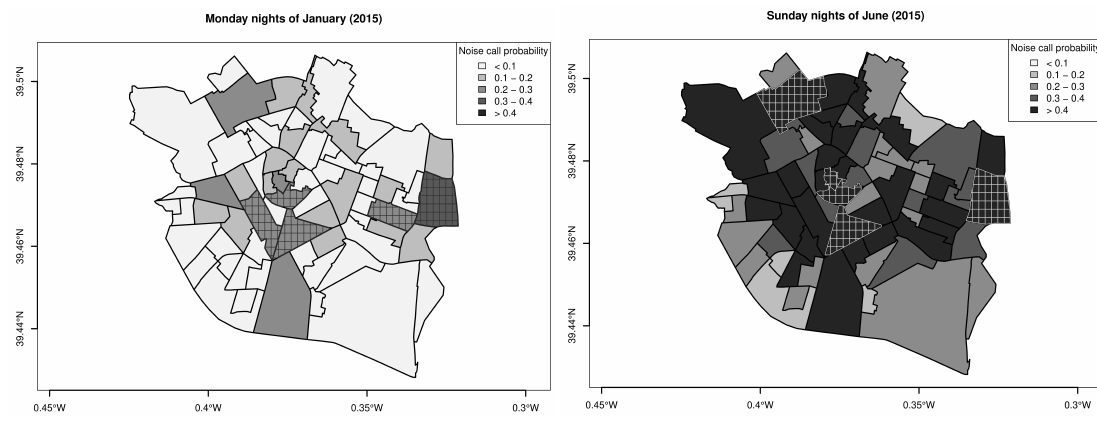
Figure 2. Probability of a noise call estimated for Monday nights of January ( left ) and Sunday nights of June ( right ) in the boroughs of València (year 2015). The five boroughs with the highest probabilities under each of the two scenarios are highlighted with a striped pattern.